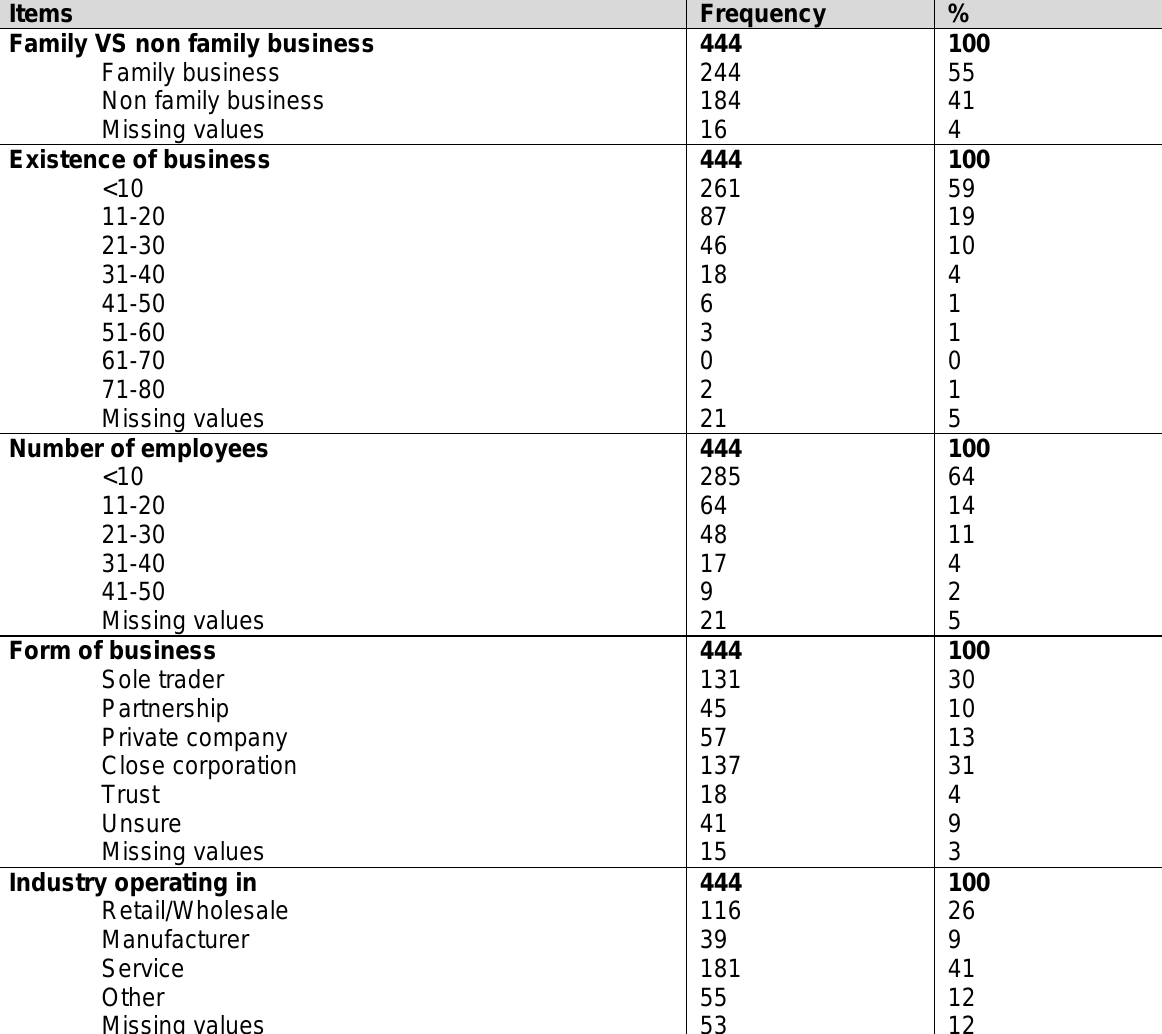
Table 3: Demographical data of businesses